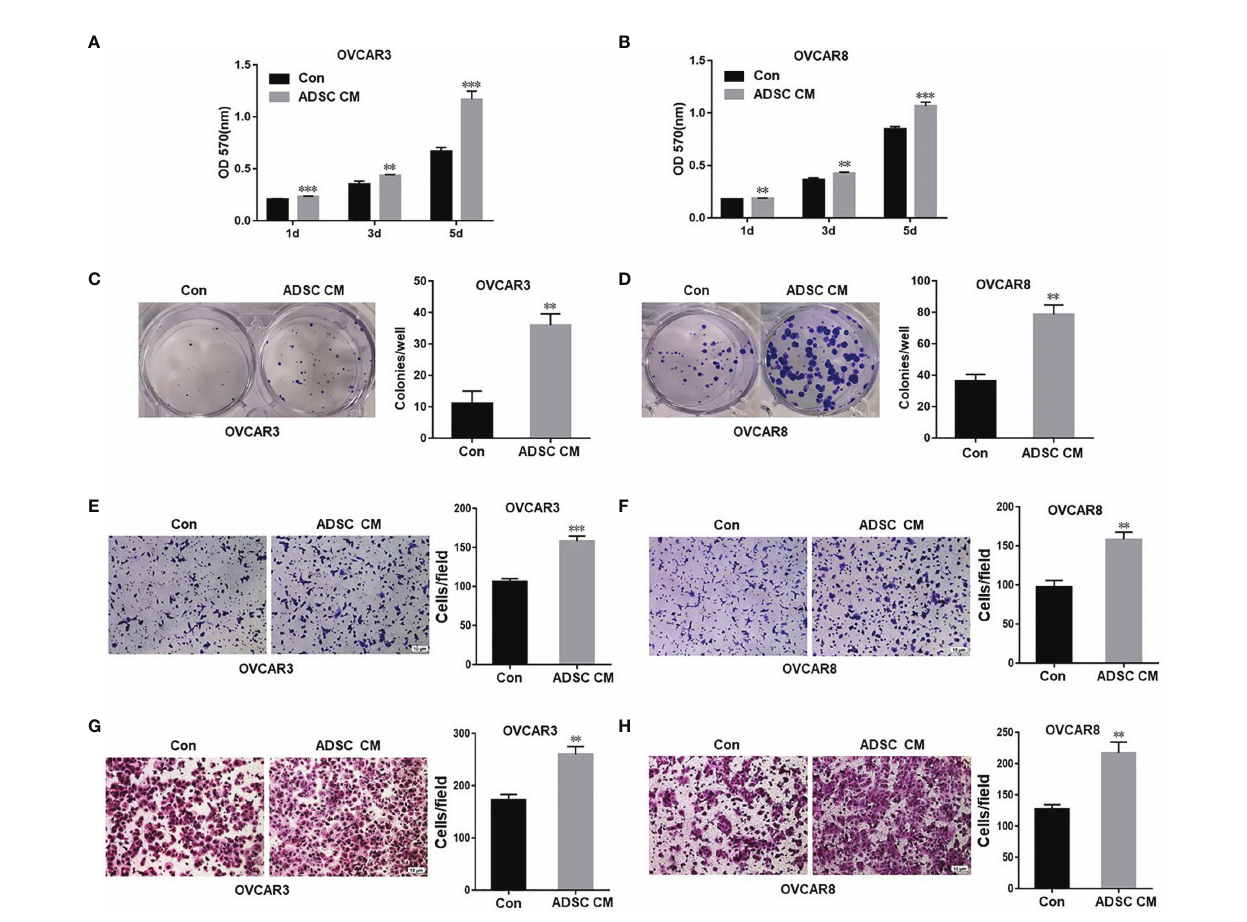
FIGURE 1 | ADSC promote cell growth, migration, and invasion in ovarian cancer cells. (A, B) MTT assay was performed to detect the cell proliferation in OVCAR3 (A) and OVCAR8 (B) cells at different time points, following treatment with ADSC-CM or control medium. (C, D) Cell colony formation assay was performed to determine cell survival in OVCAR3 (C) and OVCAR8 (D) cells treated with ADSC-CM or control medium. (E, F) Cell migration in OVCAR3 (E) and OVCAR8 (F) cells treated with ADSC-CM or control medium performed using Transwell plates. (G, H) Cell invasion in OVCAR3 (G) and OVCAR8 (H) cells treated with ADSC-CM or control medium examined using Matrigel-coated plates. Data represent the mean ± SD of three independent experiments. ** p < 0.01, *** p < 0.001 compared with the control